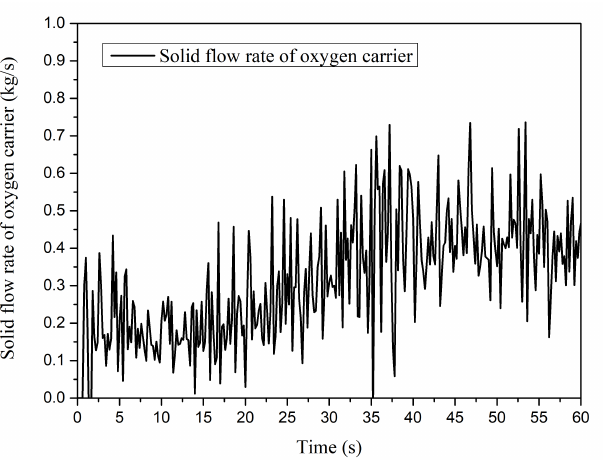
Figure 3. Flow pattern of solid phase in CLC reactor.